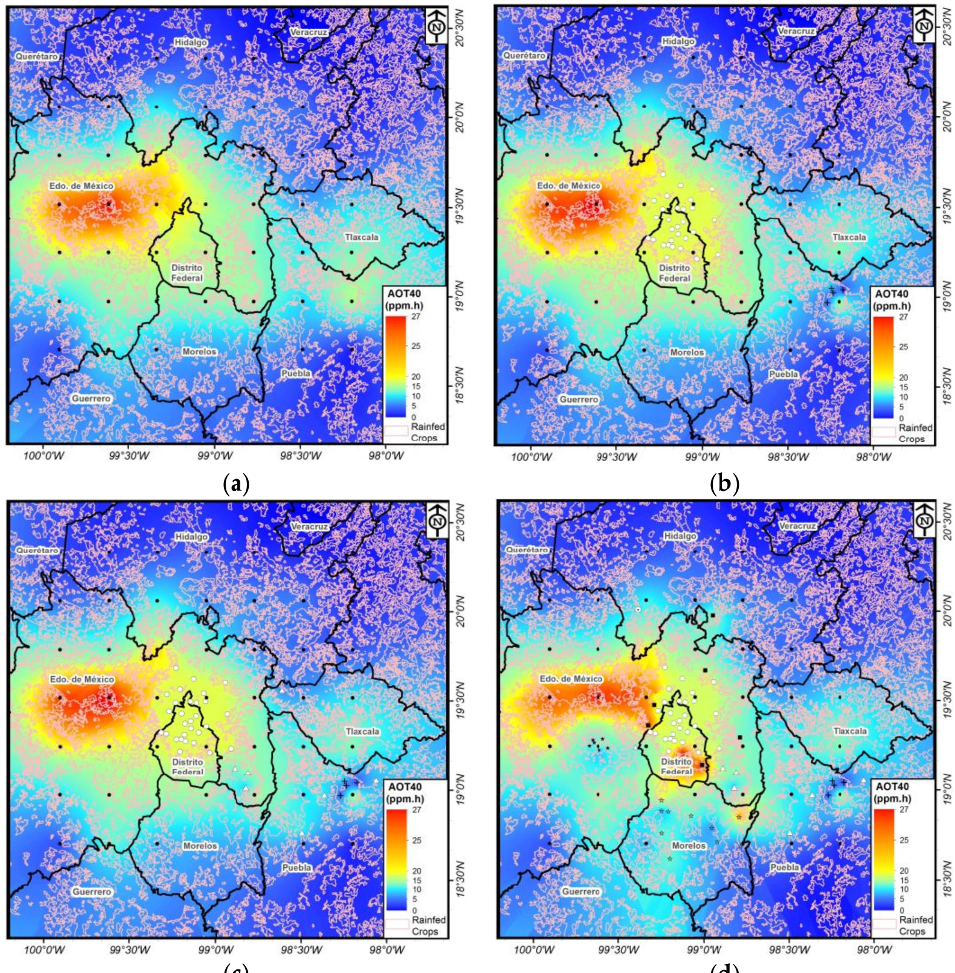
Figure 4. Evolution of the hybrid exceedance maps as observational data were gradually added to correct the maps obtained only with the air quality model. ( a ) Using only modeled and corrected regular grid points. ( b ) Panel (a) + RAMA + REMA. ( c ) Panel (b) + Garc í a-Yee + Barrera-Huertas. ( d ) Panel (c) + MILAGRO + CARIEM +